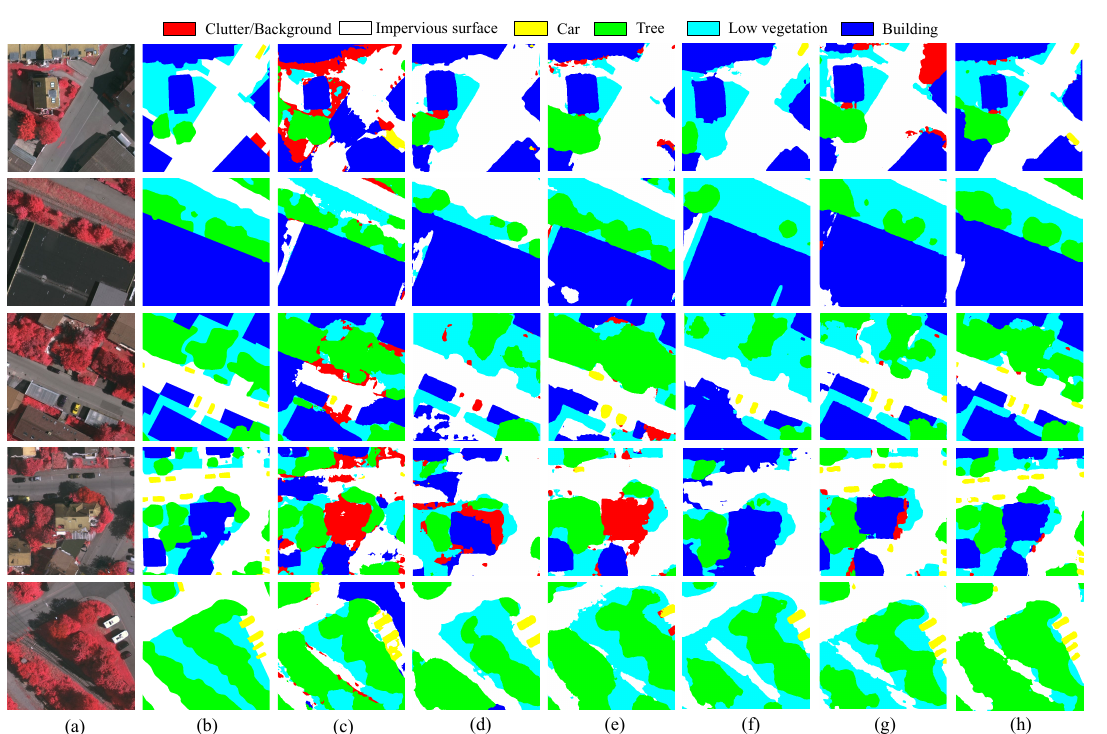
Figure 8. Qualitative results of the cross-domain semantic segmentation on Potsdam IRRG → Vai- hingen IRRG. ( a ) Target images. ( b ) Ground truth. ( c ) Baseline. ( d ) GAN-RSDA. ( e ) AdaptSegNet. ( f ) MUCSS. ( g ) RDG-OSA and ( h )